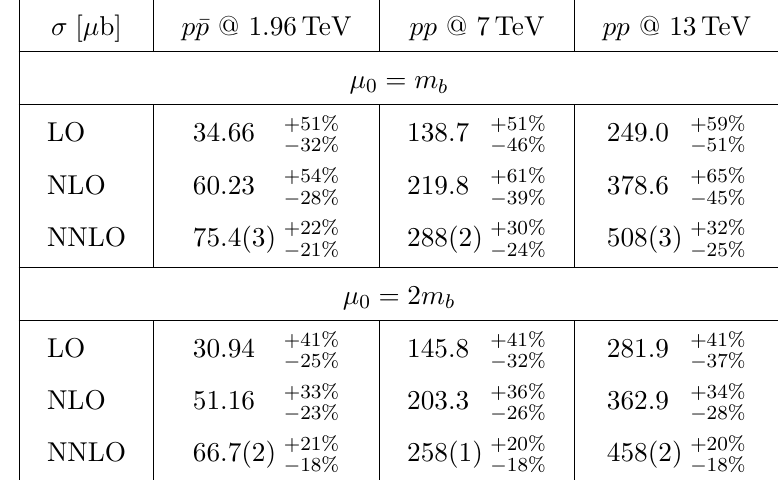
The NNLO total cross section for b (cid:22) b production at the Tevatron and at the LHC: comparison of our results with those obtained by using Hathor . The quoted uncertainties are obtained through scale variations as described in the text. Numerical errors on the last digit are stated in brackets (and include the uncertainties due to the r cut 0 extrapolation). !